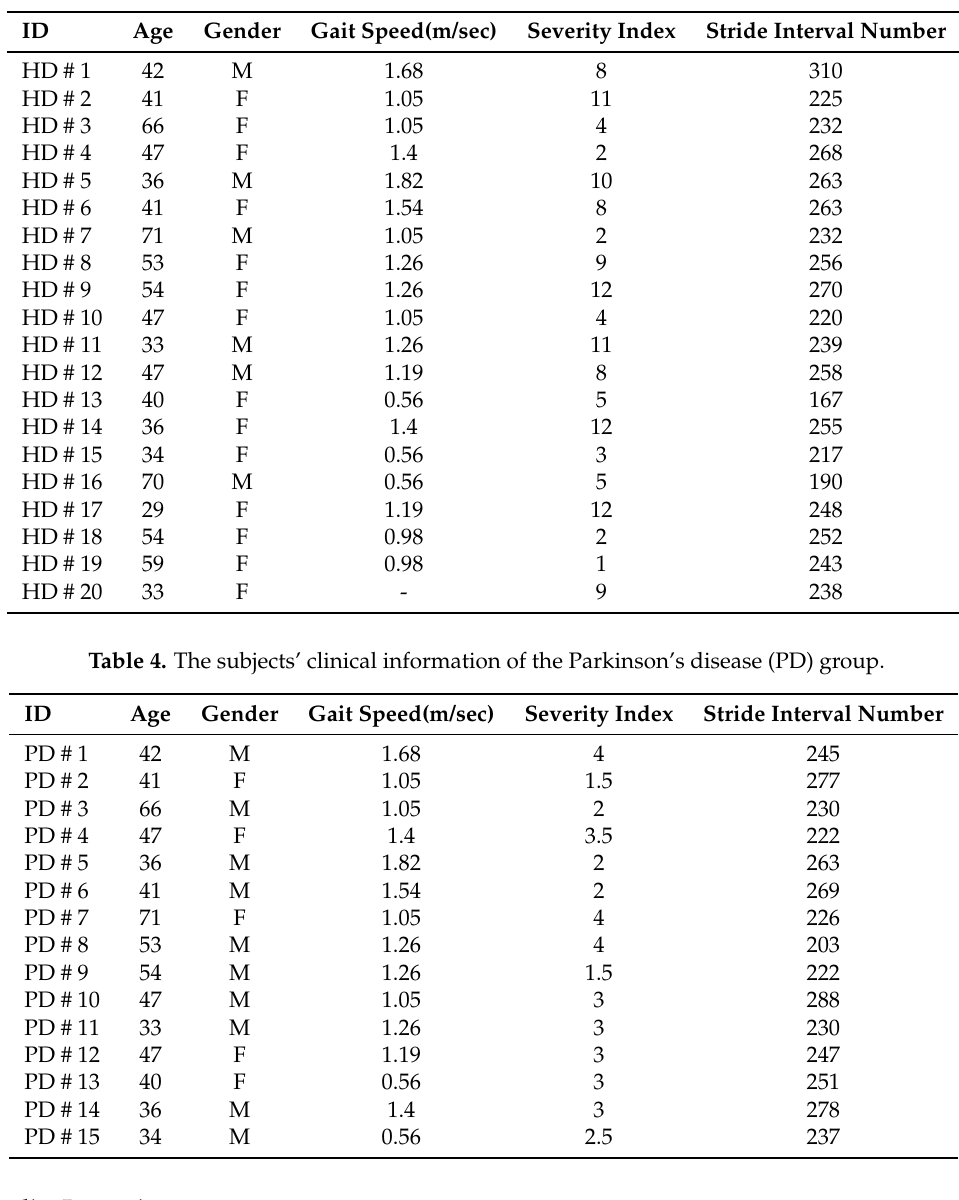
Table 3. The subjects’ clinical information of the Huntington’s disease (HD) group.